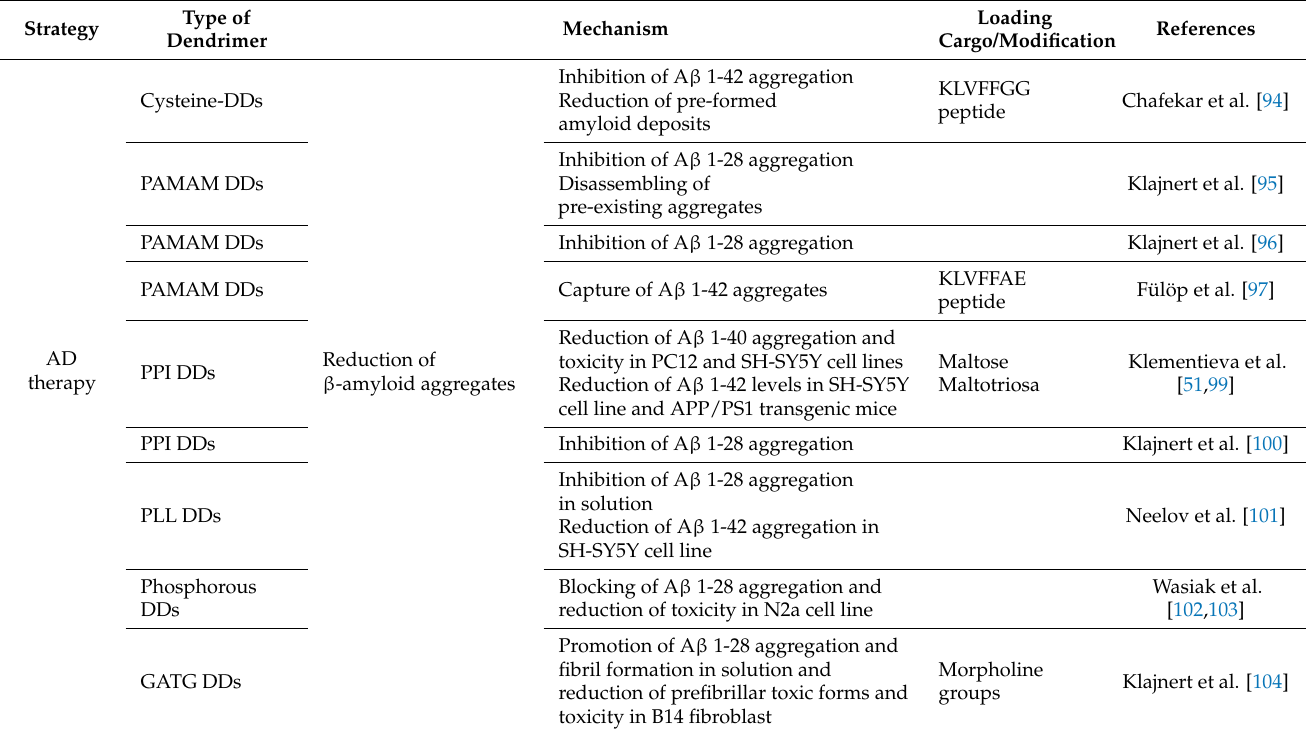
Table 1. DDs for AD therapy and diagnosis. Abbreviations: AD (Alzheimer’s disease), GATG (gallic acid-triethylene glycol), DD (dendrimer), PLL (poly-L—lysine), DGL (dendrigraft poly-L-lysines), NFT (neurofibrillary tangles), BACE1 ( β -amyloid converting enzyme 1), PEG (polyethylenglicol), AChE